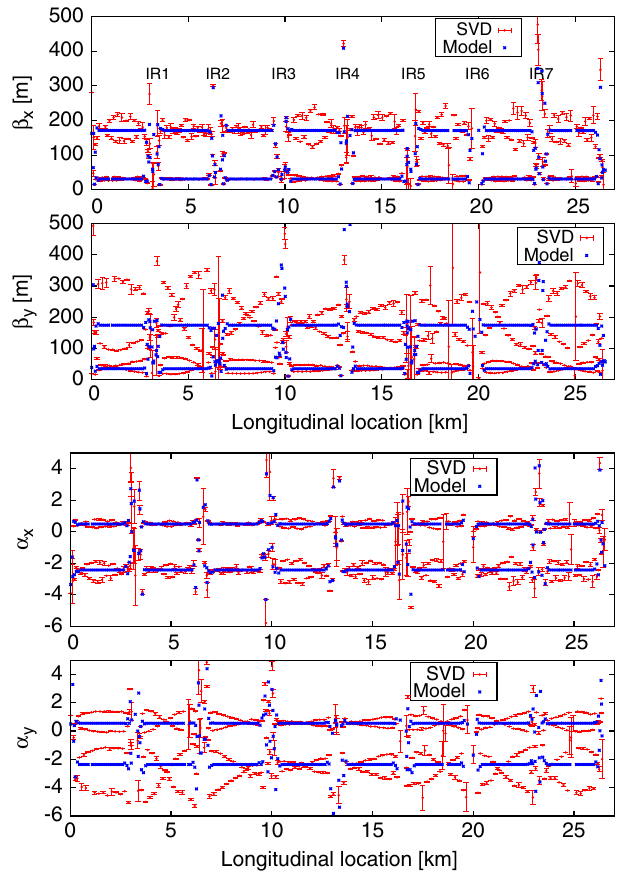
FIG. 3. (Color) Measured (cid:2) functions (top two plots) and (cid:4) functions (bottom two plots) for the LHC beam 2 together with the design